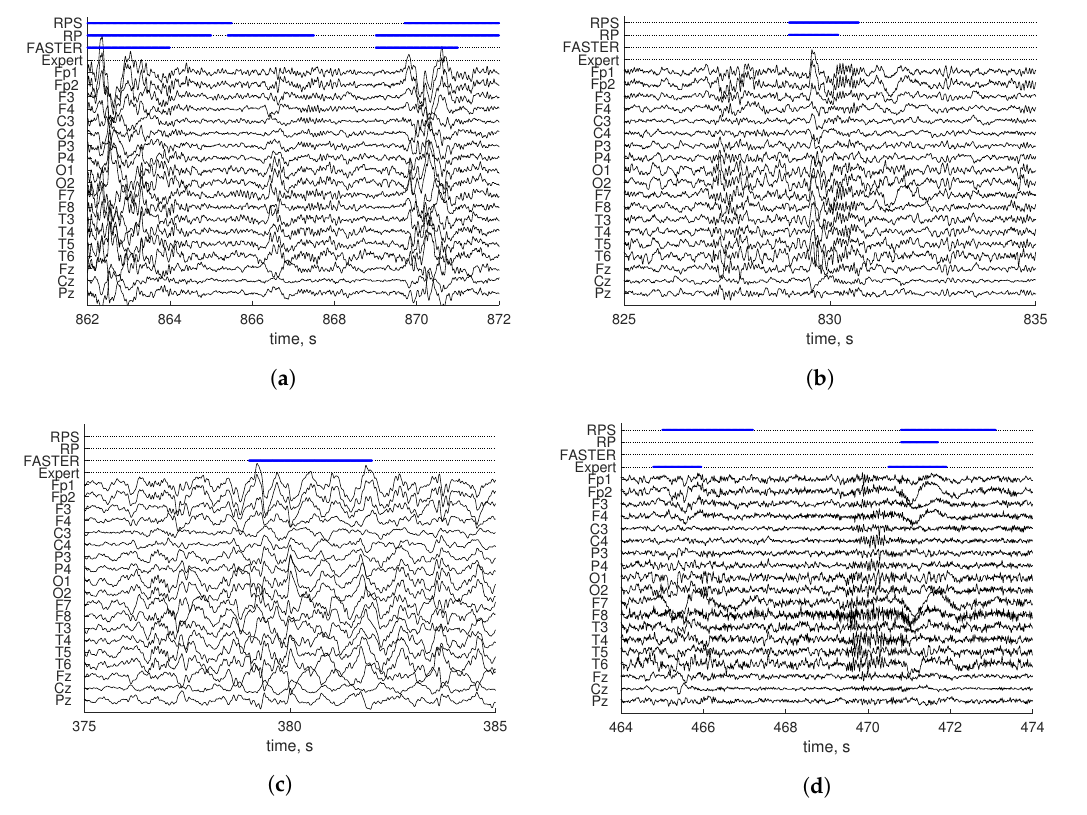
Figure 9. Expert scoring (Expert), results of the FASTER (FASTER), benchmark (RP), and the proposed (RPS) methods of different EEG patterns in delta waves ( a ), k-complex in non-REM 2 ( b ), delta waves in non-REM 3 ( c ), and ocular artifact in REM ( d